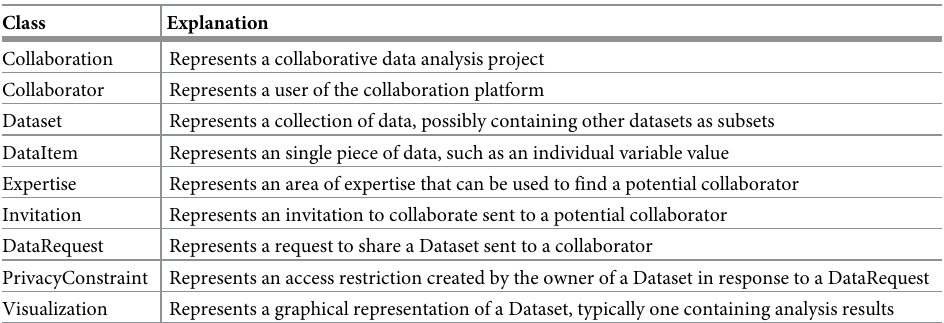
Table 1. Main classes of the collaboration